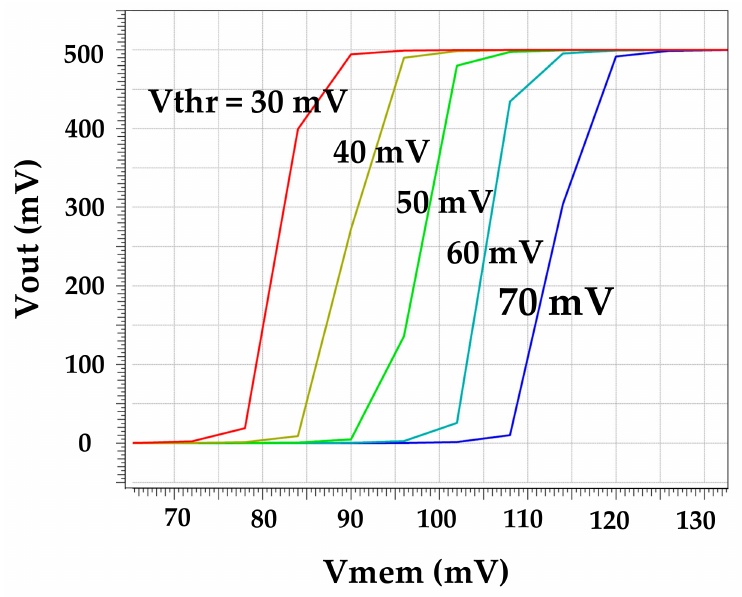
Figure 8. The relationship between the output voltage V out and the membrane voltage V mem under different reference voltages V thr varied from 30 mV to 70